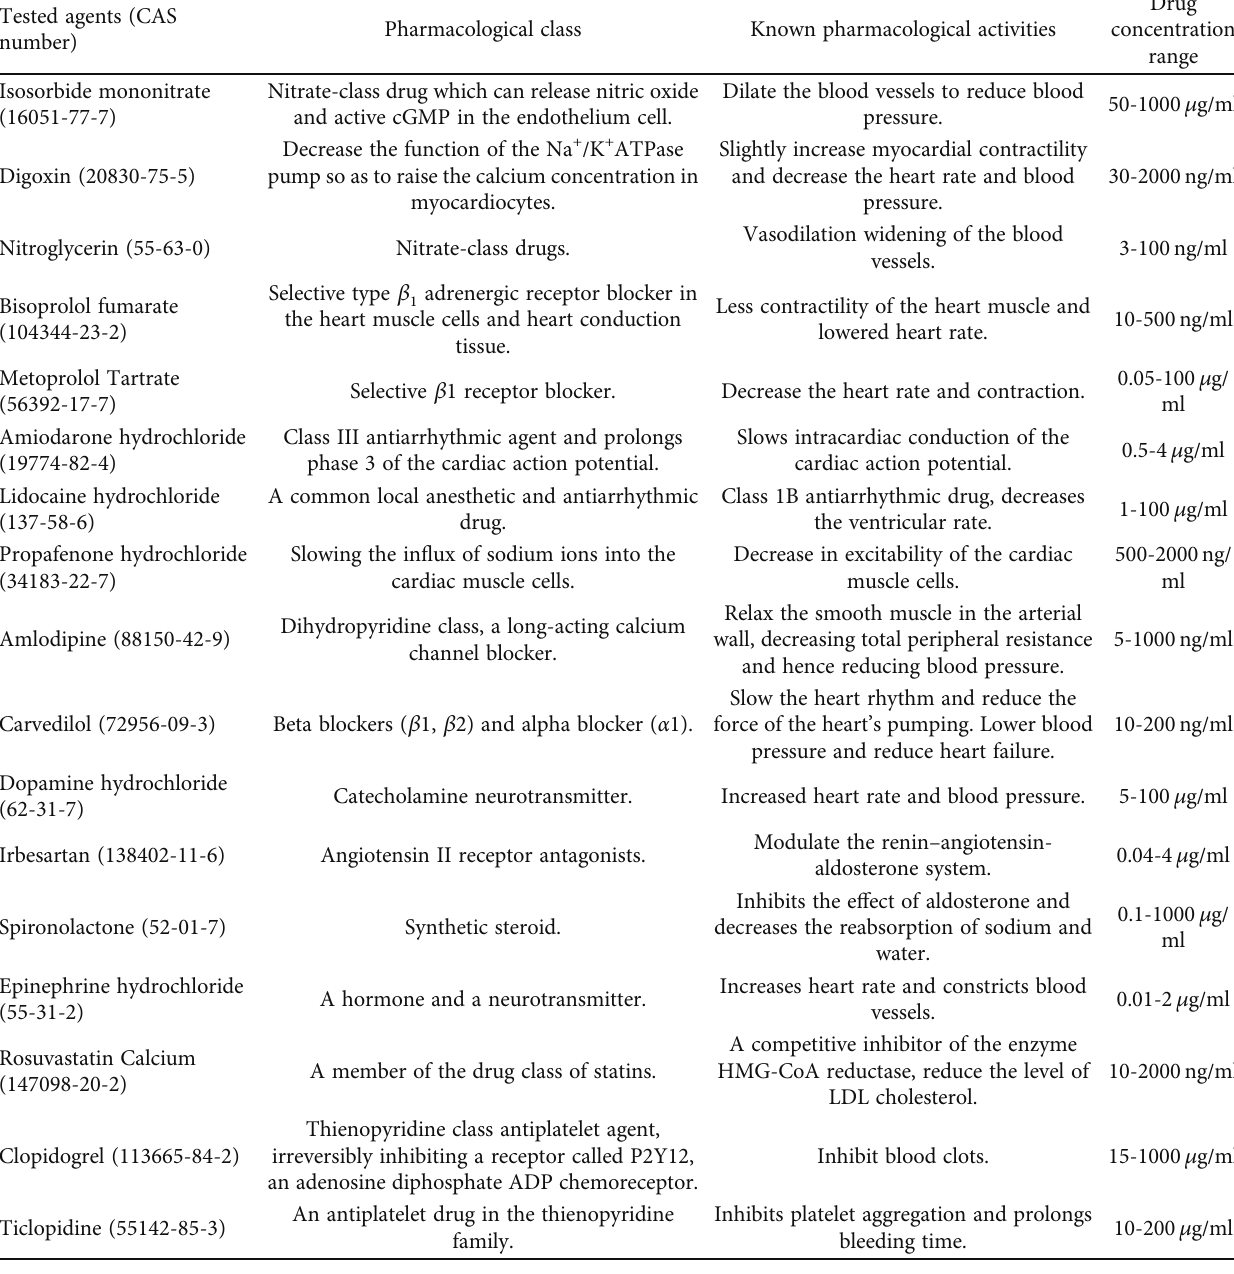
Table 1: Blood compound concentration in